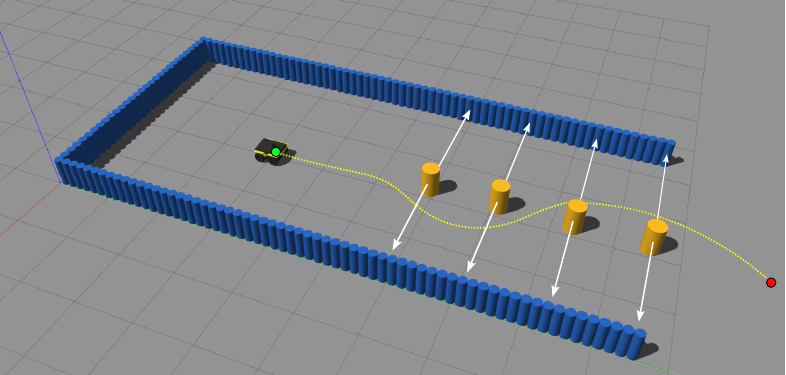
Figure 12. Environment used to test obstacle avoidance with dynamic obstacles. While the robot moves toward the goal, the four yellow obstacles move back and forth with random velocities.